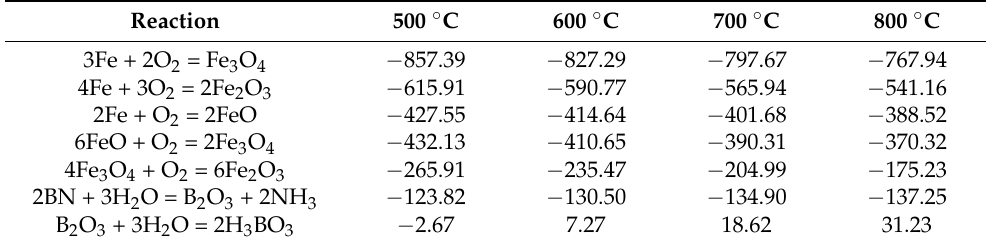
Table 2. The Gibbs free energy of the friction pair ( ∆ r G θ m